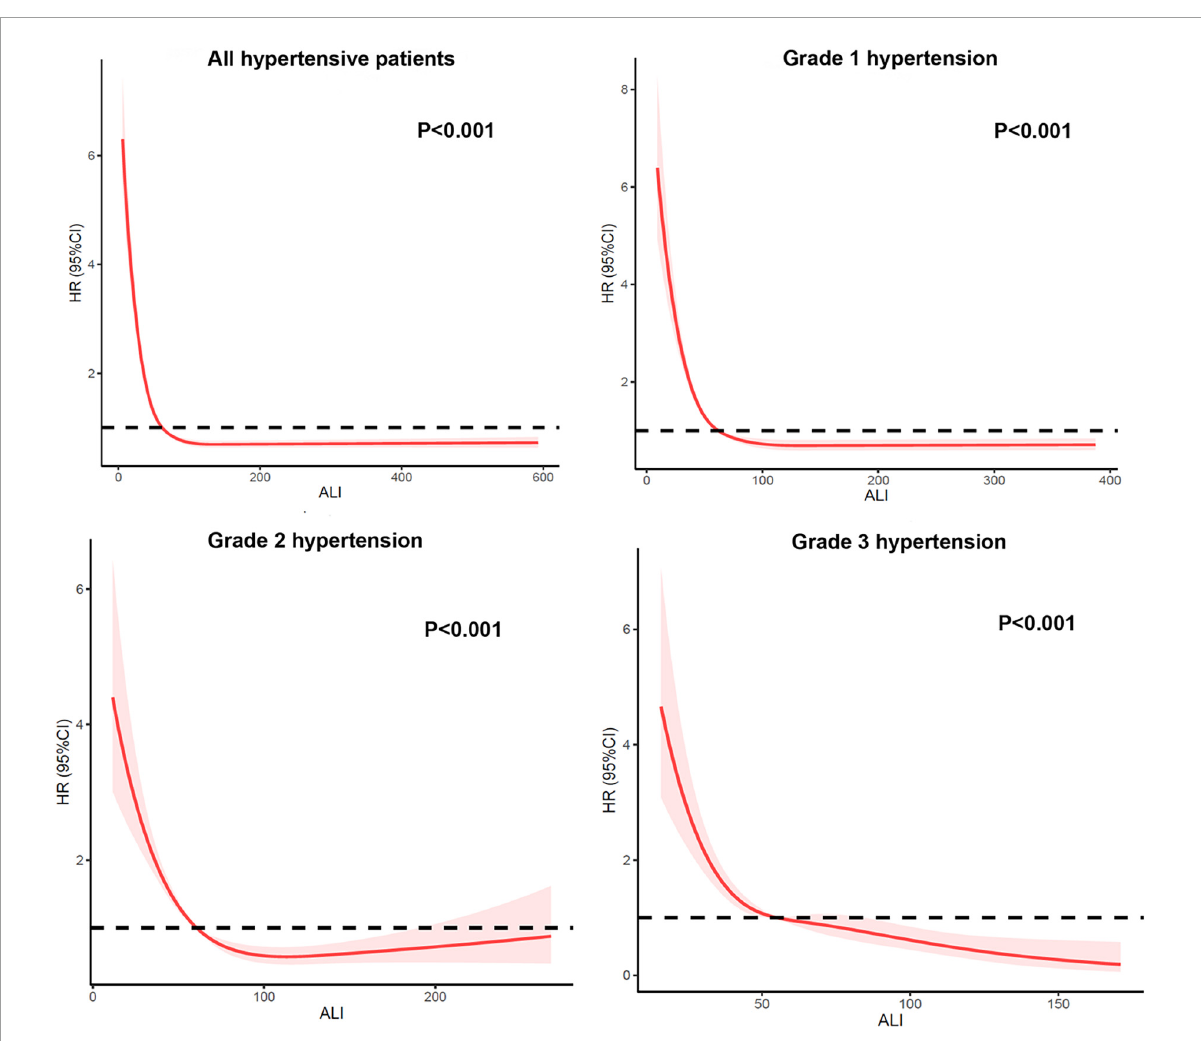
FIGURE3 Restricted cubic spline of hazard ratios (HRs) and 95% CI for the association between ALI score (continuous) and all-cause mortality